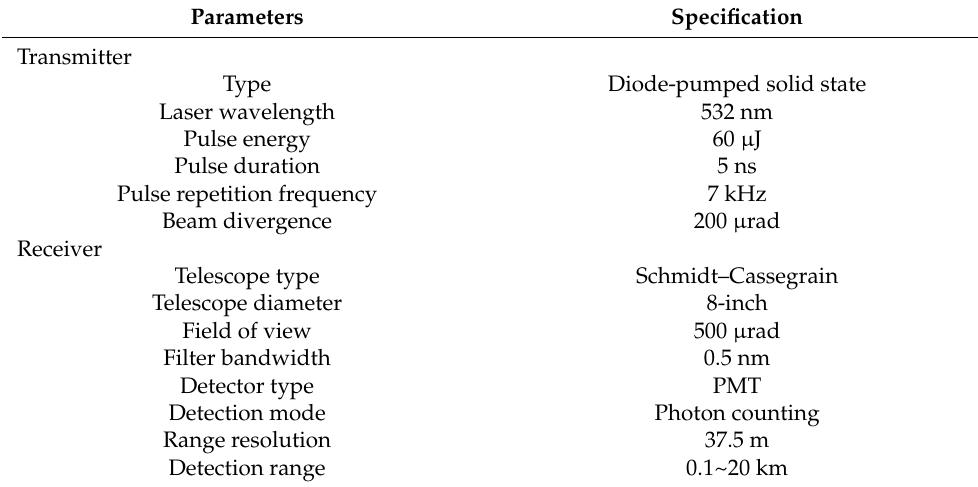
Table 1. The specifications of the P-MPL.